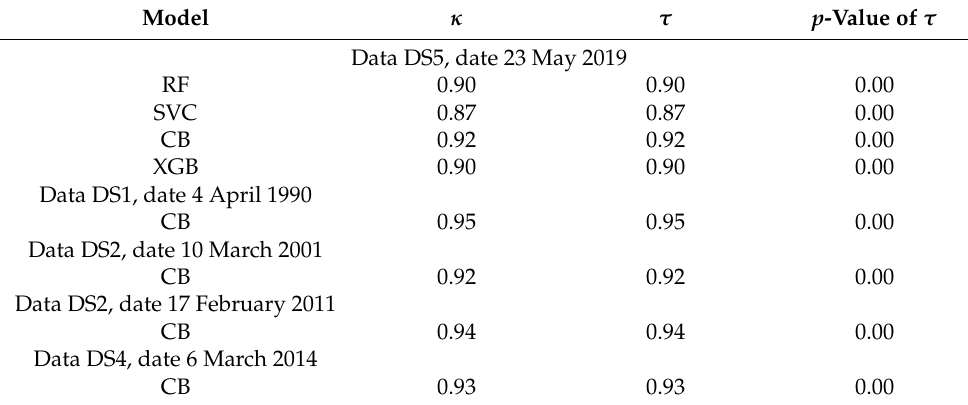
Table A4. Kappa and Kendall’s tau coefficients of the classification. Model